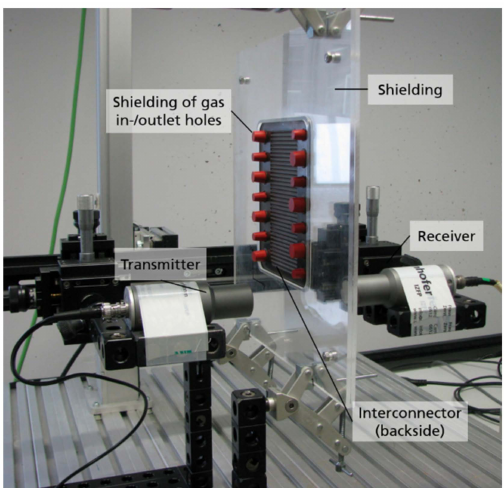
Figure 6. Setup for air-coupled ultrasound measurements with shielding measures against unwanted sound